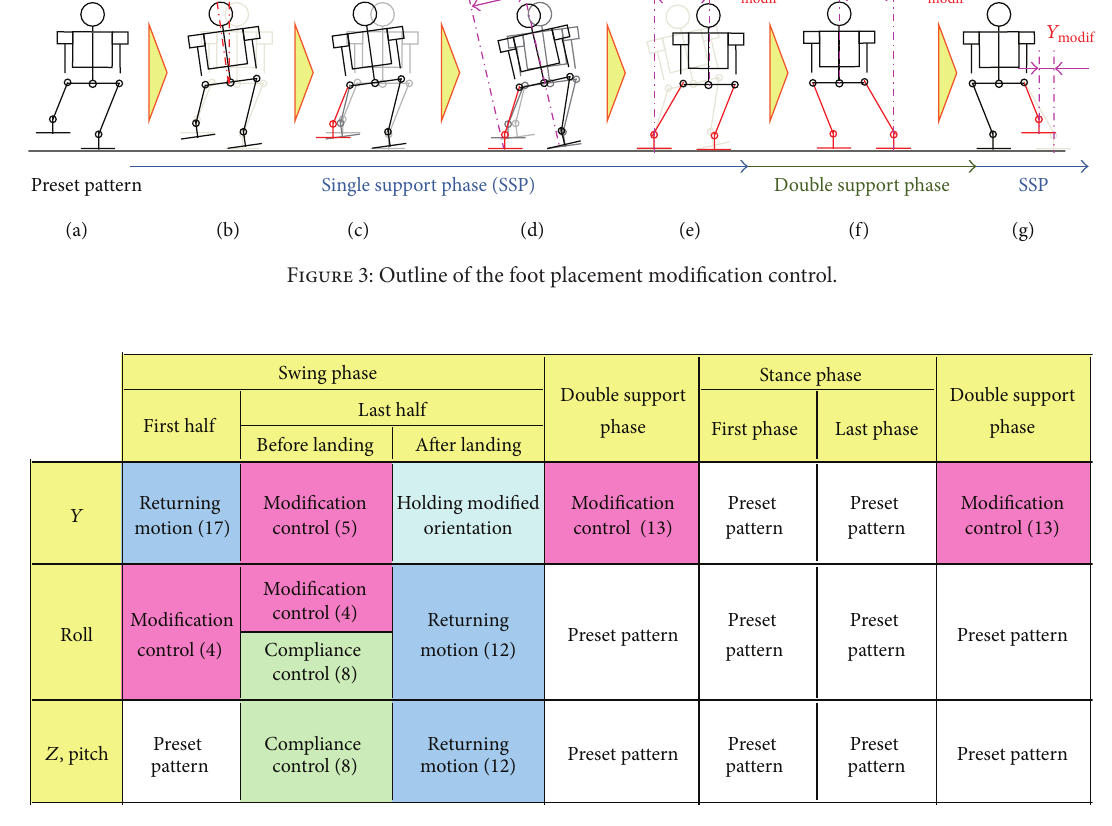
Figure 4: Timing chart of the foot placement modification